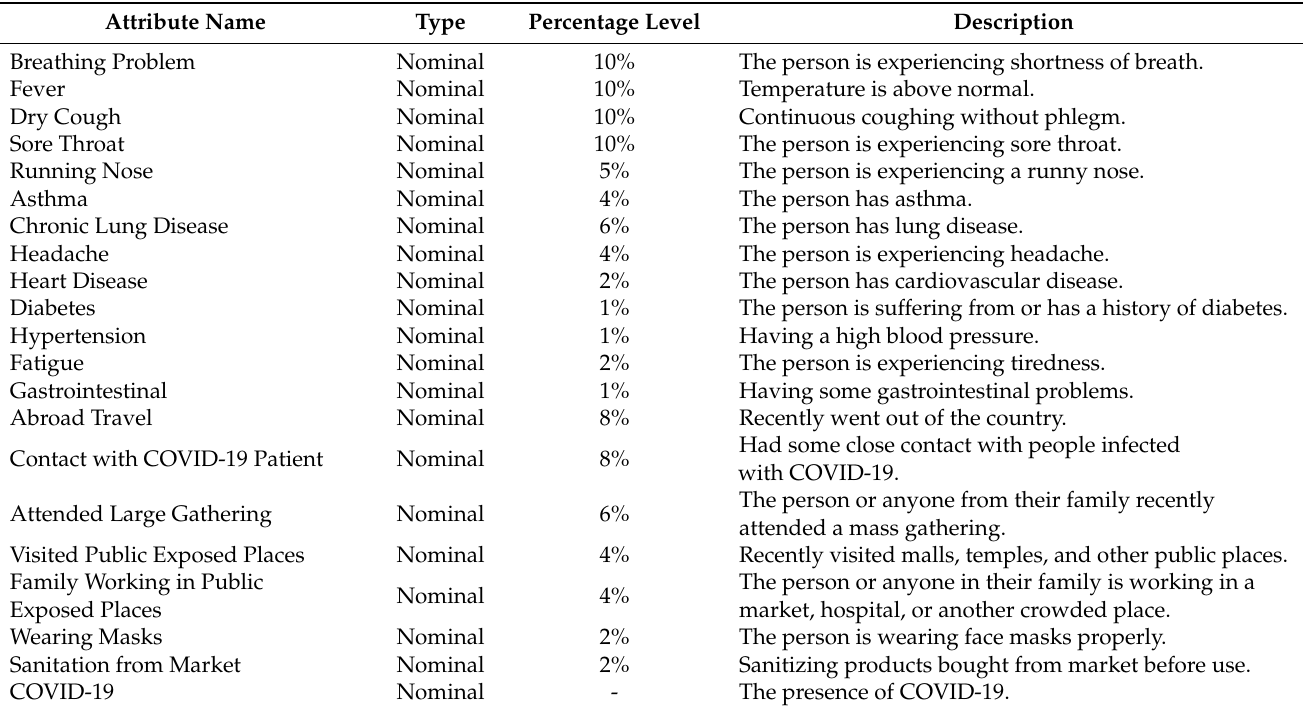
Table 2. Features, percentage level and attribute descriptions of the COVID-19 symptoms and presence dataset.